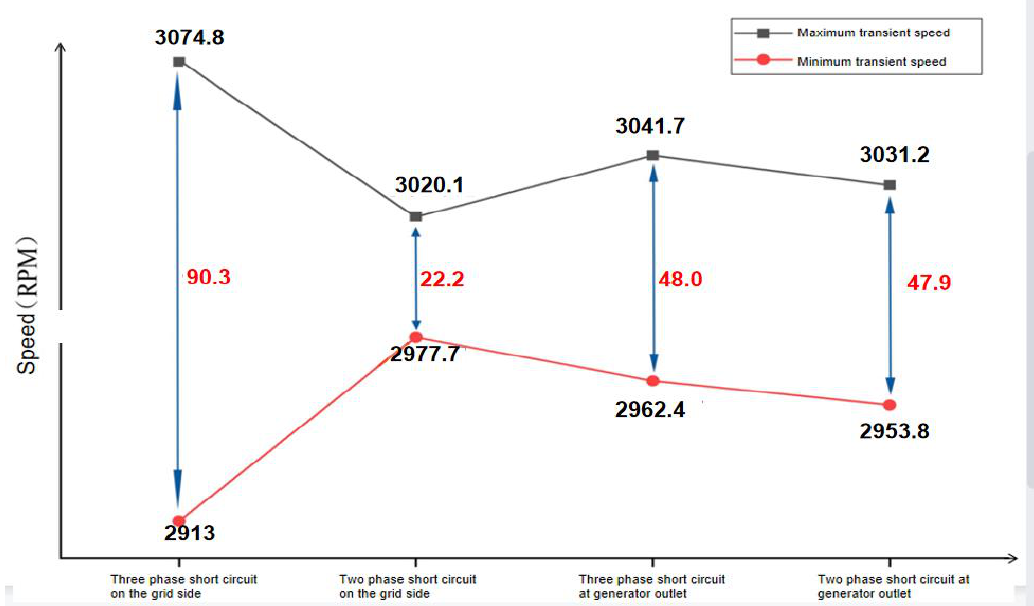
Figure 12. Speed deviation of steam turbine and generator under different short-circuit faults.